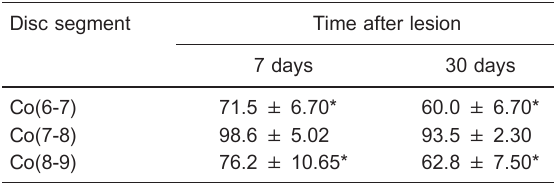
Table 2. Percentage of disc height index (%DHI).